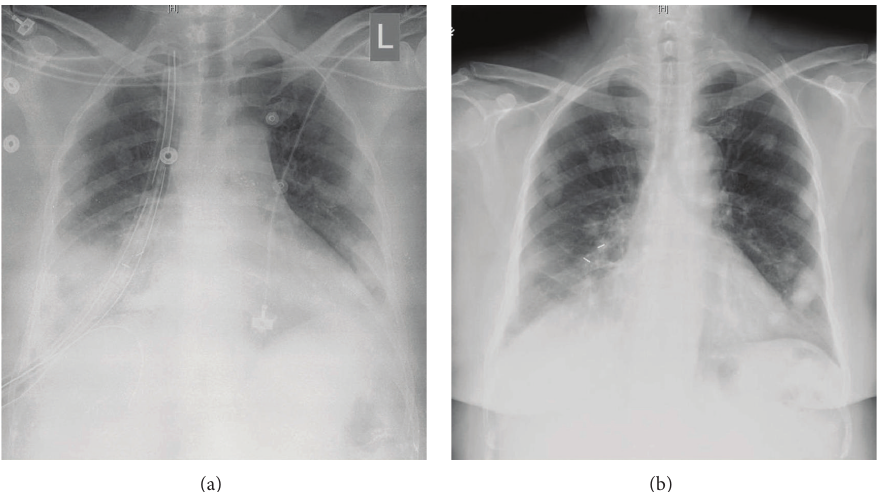
Figure 5: (a) CXR taken on postoperative day 1 which shows significant resolution of the fluid collection from the right hemithorax; (b) CXR taken on post-operative day 16 which shows complete resolution of the fluid collection from the right